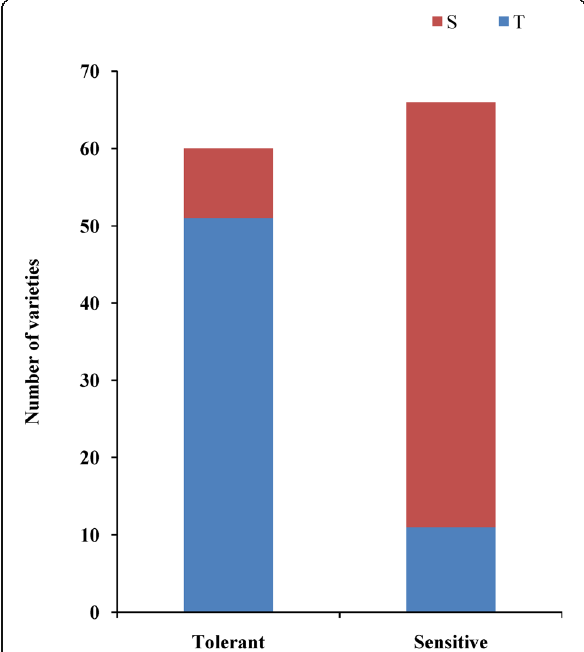
Fig. 6 The distribution of tolerant genotype and sensitive genotype in 126 japonica rice varieties. T (blue box) indicates tolerant genotype without the 7 bp sequence, S (red box) indicates sensitive genotype with the 7 bp